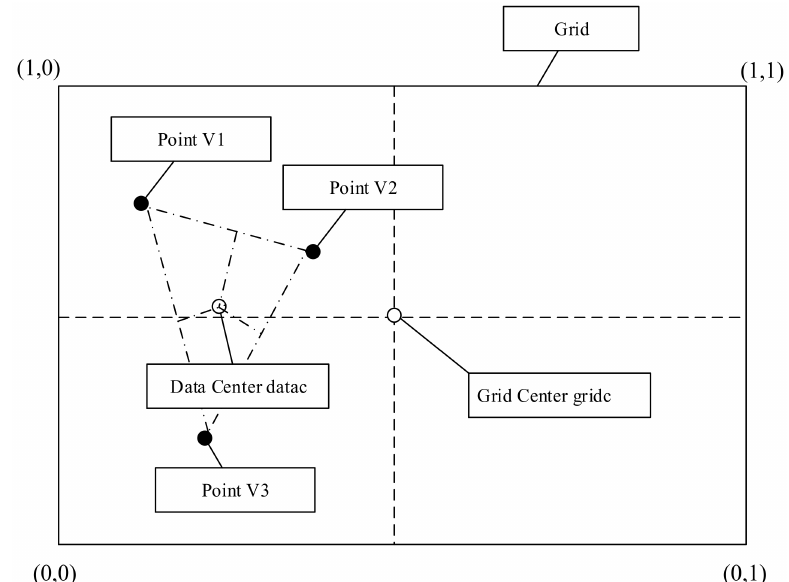
Figure 1. Data center point and grid center point.